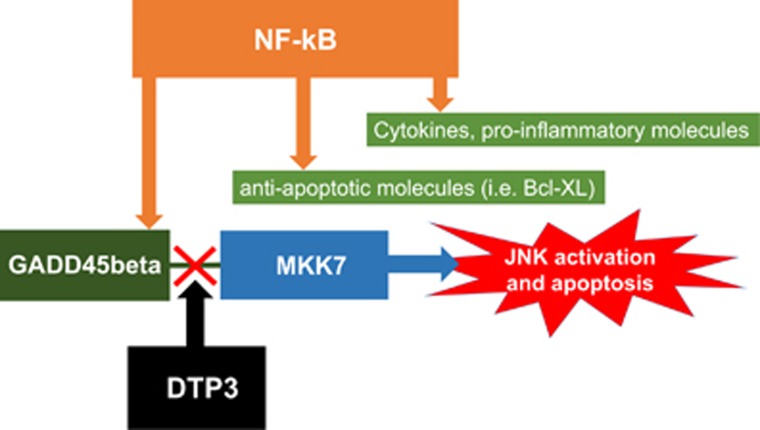
NF-κB downstream signalling and DTP3 action